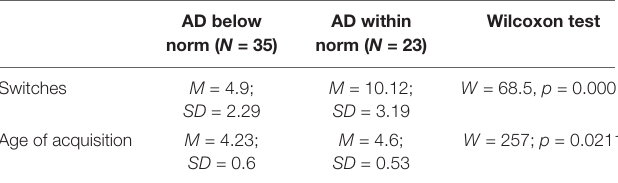
TABLE 2 | Cross-validation of results with non-parametric